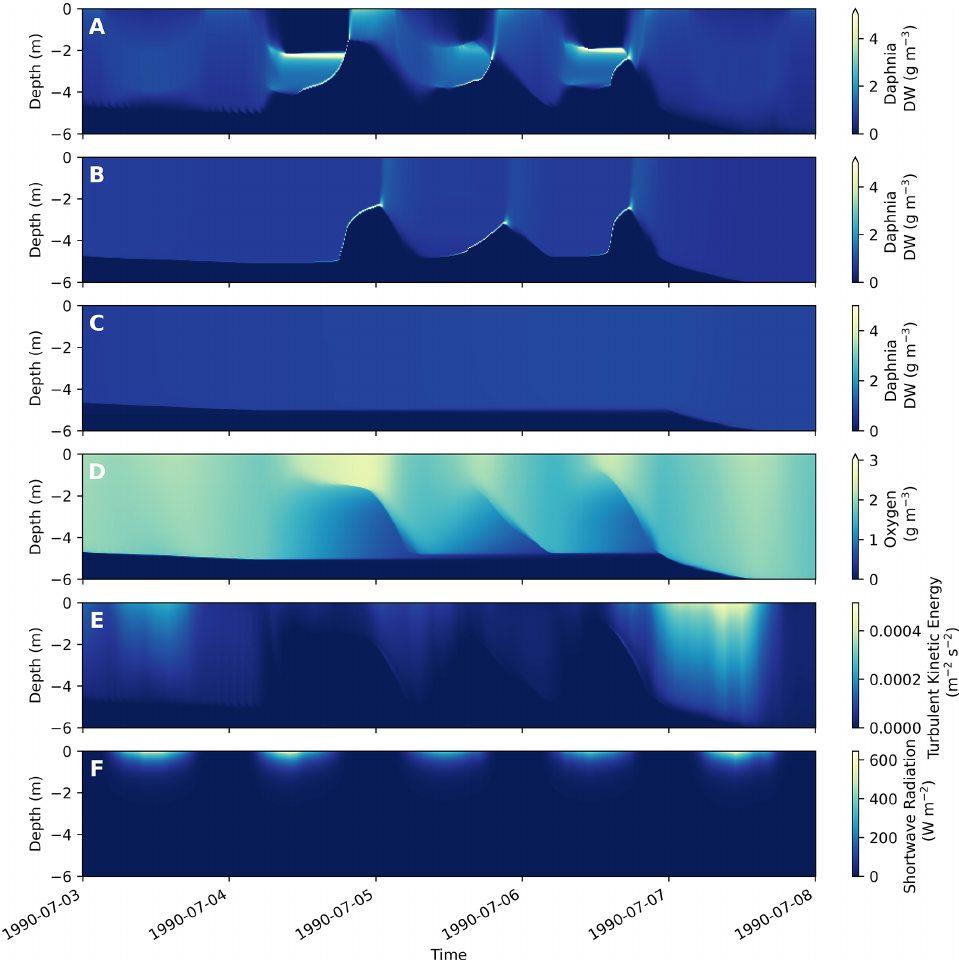
Figure 6. Example of simulated vertical migration in WET. Output from the upper 6m of Lake Bryrup during 5d in July 1994, as simulated by WET coupled to the 1D GOTM lake model. (a) Vertical distribution of Daphnia dry-weight biomass, with vertical movement set to light-based vertical movement. Note the vertical movements of zooplankton biomass, triggered by light intensity in the water column, as well as oxygen depletion in the hypolimnion and modulated by turbulent mixing. (b) Vertical distribution of Daphnia dry-weight biomass, with vertical movement set to hypoxia avoidance. (c) Vertical distribution of Daphnia dry-weight biomass, with vertical movement set to passive transport only. (d–f) Oxygen, turbulent and light conditions, respectively, which inform the vertical movement of zooplankton. For legibility of the figure, the maximum color bar cutoff has been set at a lower value than brief and localized very high Daphnia concentrations ( ∼ 30gm − 3 ) during the anoxia avoidance episodes. (b) Downwelling shortwave radiation. For these simulations, Daphnia vertical movement parameters were set to Vswim = 45md − 1 , cMaxLight = 40.0Wm − 2 , cMinLight = 0.15Wm − 2 and cMinO2 = 2.0gO 2 m − 3